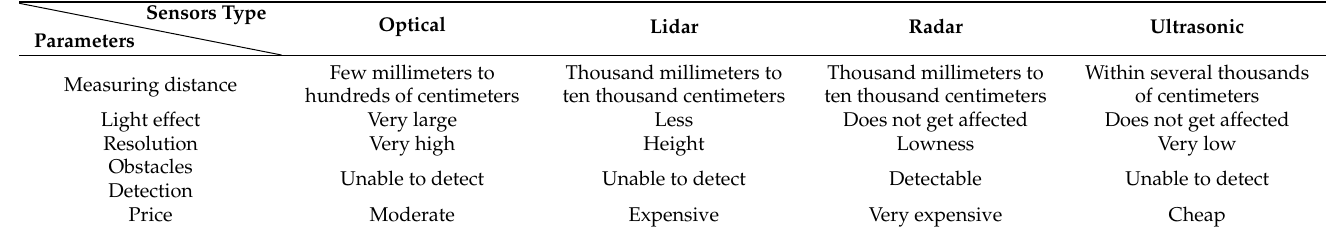
Table 1. Comparing the different types of sensors types and their